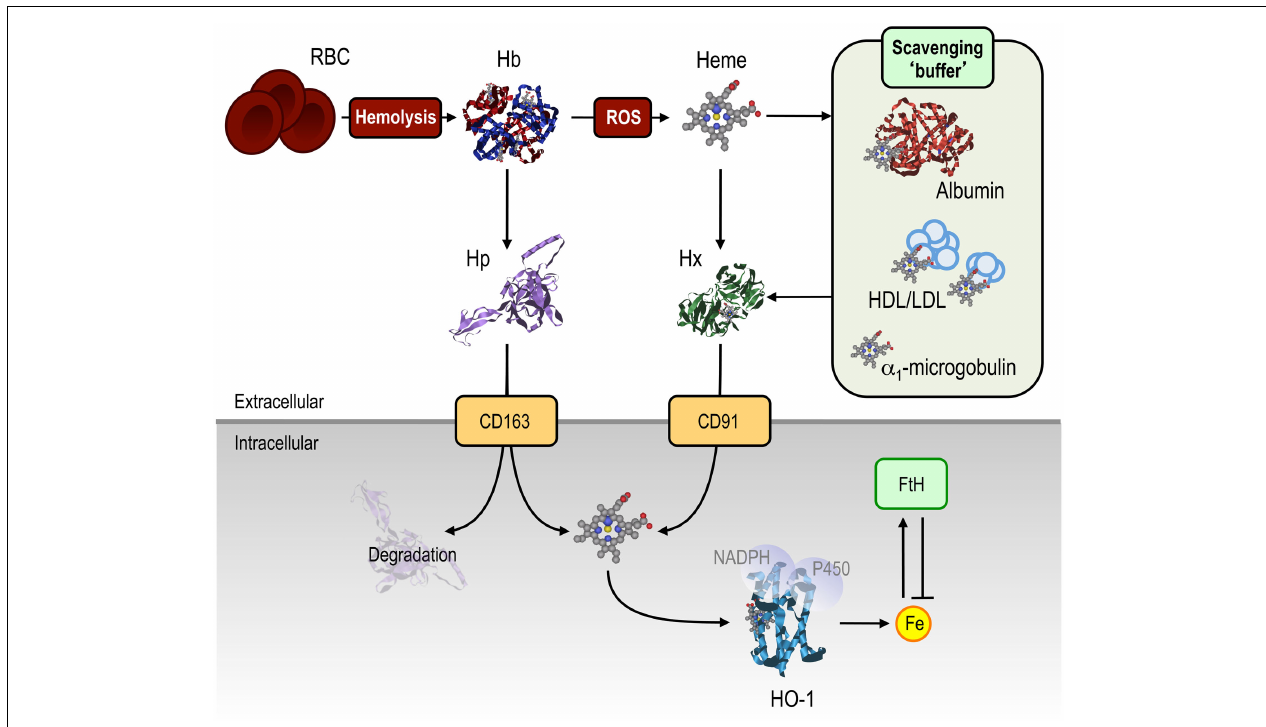
has the highest affinity for free heme. Hx:heme complexes are taken up via the CD91 receptor, delivering heme for catabolism by HO-1. Intracellular heme, whether originating from the extra- or intracellular compartment, is degraded via HO-1.The labile Fe released from heme catabolism is subsequently scavenged by FtH, thus conferring cytoprotection against heme-Fe. Abbreviations: Fe, iron; FtH, ferritin; Hp, haptoglobin; Hb, hemoglobin; HDL/LDL, high/low-density lipoprotein; Hx, hemopexin; ROS, reactive oxygen